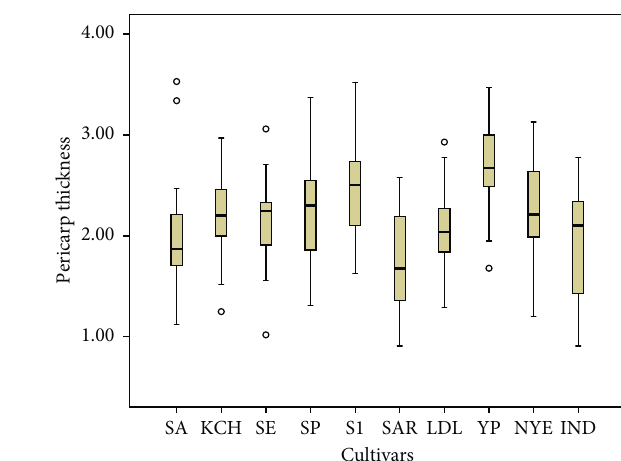
Figure 12: Percent fruit set.